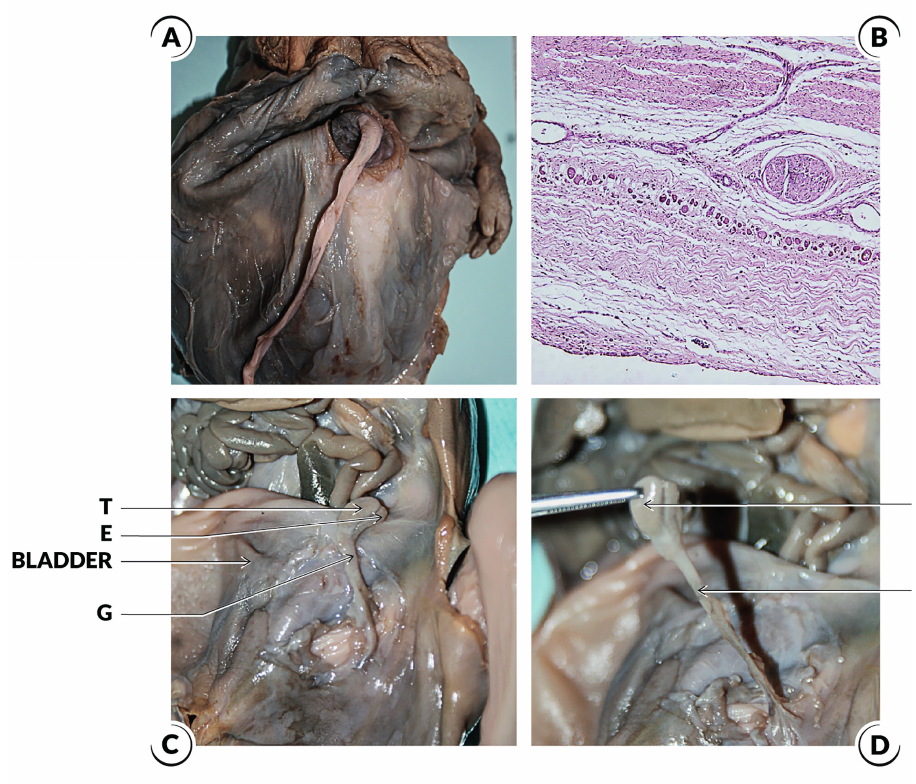
Figure 4 - Prune Belly Syndrome cases. A) The fi gure shows a male fetuses with 28 weeks post conception (WPC) and Prune Belly Syndrome; the anterior abdominal wall was dissected and we can observe the typical aspect of the abdomen in this syndrome; B) Photomicrography of the same fetuses showing the histological aspect of the abdominal wall muscles with hypoplasia in Prune Belly Syndrome; HEX200; C) In this fi gure the abdominal wall of the Prune Belly Syndrome fetus with 28WPC was dissected and we can observe an enlarged bladder and the left testis (T) situated in abdominal position very close to the bladder, we also observe the distal insertion of the gubernaculum testis (G) and the epididymis (E); and D) In this fi gure the left testis was dissected in this fetus with 28WPC and Prune Belly Syndrome to show the relationship between the testis (T) and the gubernaculum